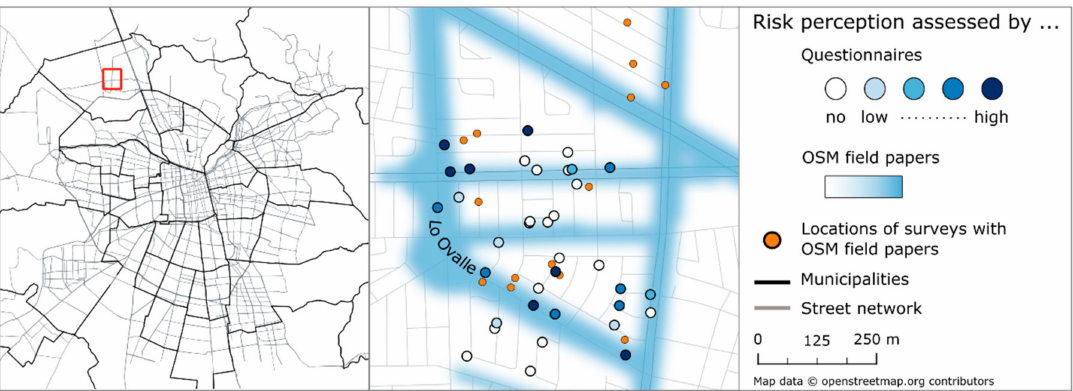
Figure 5. Quilicura: Risk perception based on the overview base maps. The blue areas summarize the results of the risk perception maps of the 14 participants while the points indicate the reference data based on the local risk perception from 36 participants; i.e., the intensity of their flood risk perception at that direct location. The darker the blue, the higher the intensity. The orange points indicate the location of the 14 participants during the survey with the OSM field